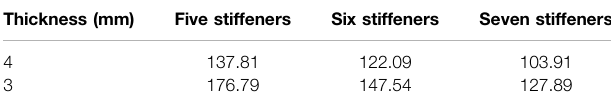
TABLE 5 | The maximum stress of each model